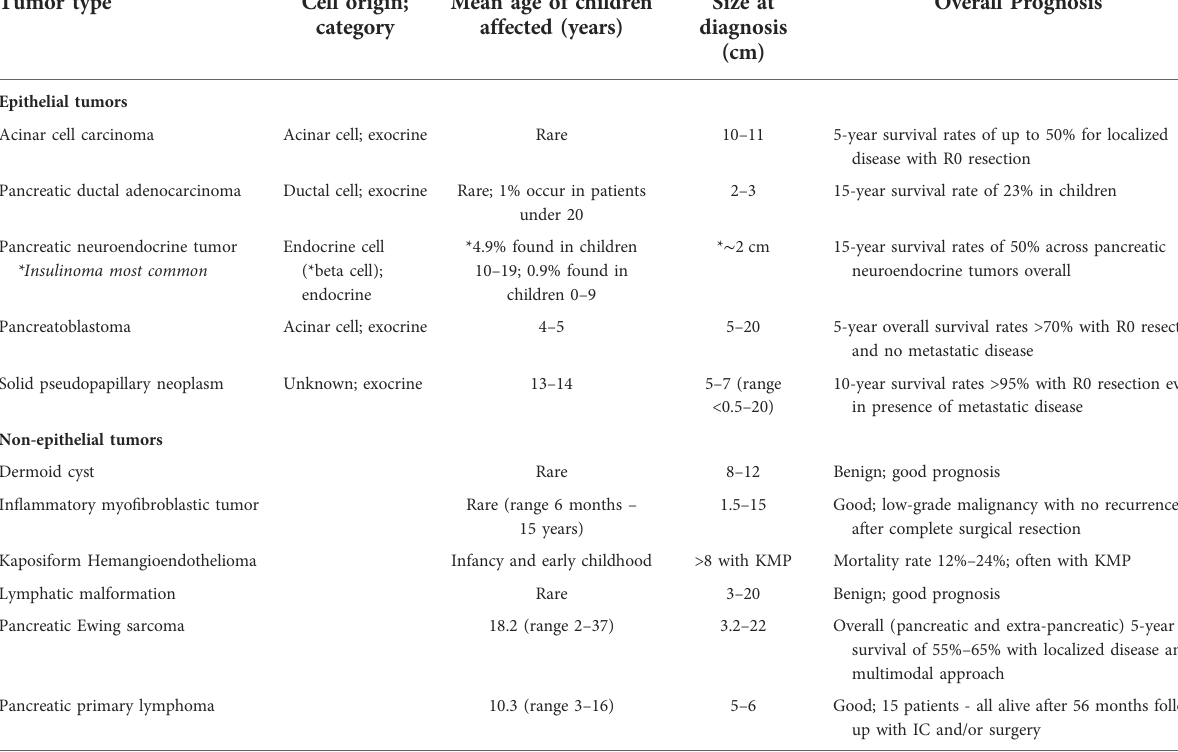
TABLE 1 Solid pancreatic tumors diagnosed in children with associated clinical